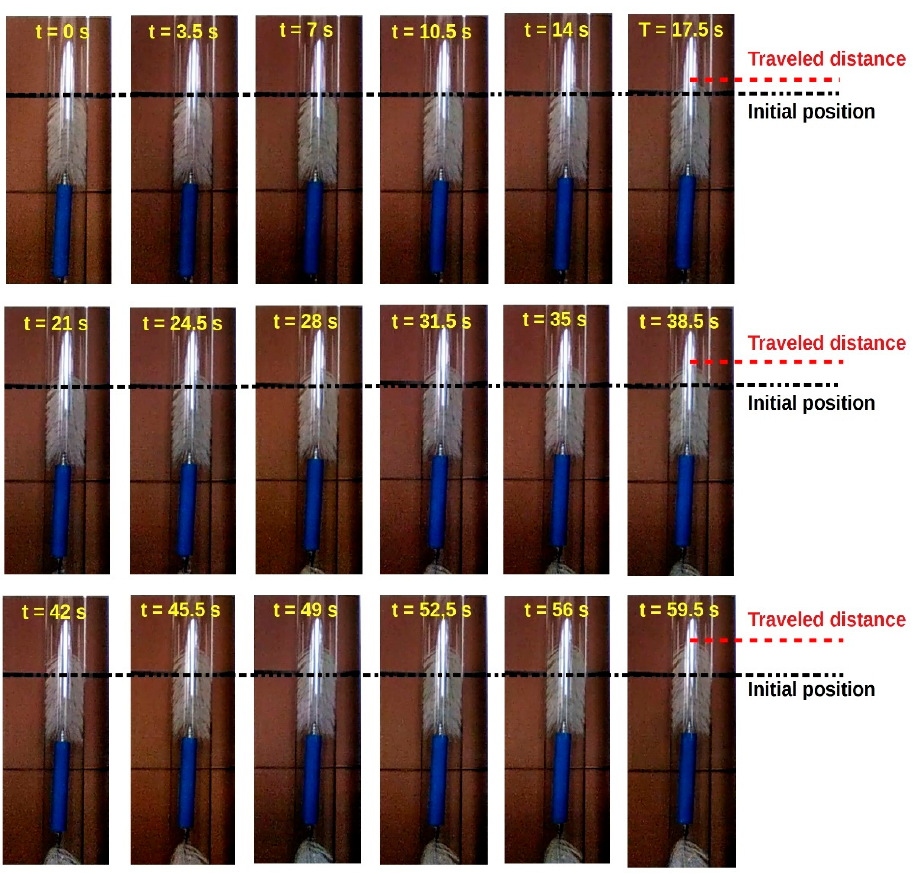
Figure 6 . Video sequence of robot motion . Figure 6. Video sequence of robot